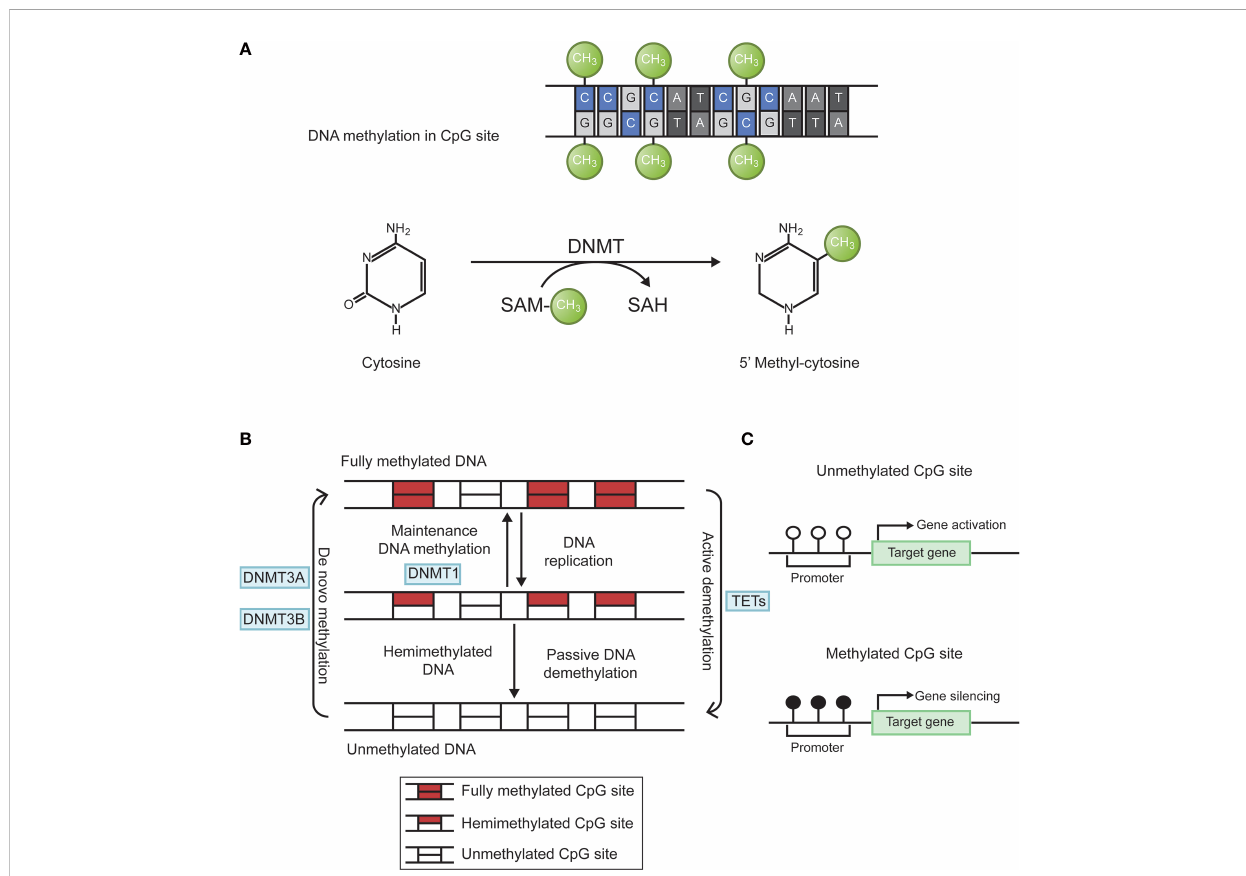
FIGURE 1 Biological process of DNA methylation. (A) Cytosine is catalyzed by DNMTs to form 5 ‘ methyl-cytosine, with SAM as the methyl donor. (B) DNA methylation is dynamically regulated by DNMTs and TETs. Figure 1-B adapted from Jeltsch (26). (C) Hypermethylation of target gene promoter causes gene silencing. DNMTs, DNA methyltransferases; SAM, S-adenosyl methionine; CpG, cytosine-guanine; TETs, ten-eleven translocation